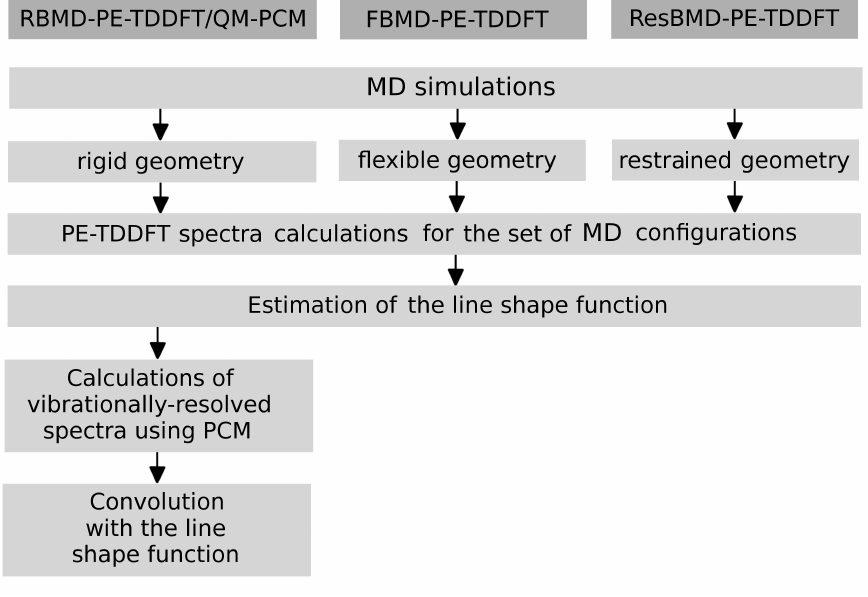
Figure 5. Schematic representation of the computational protocol used in this work to estimate the absorption band